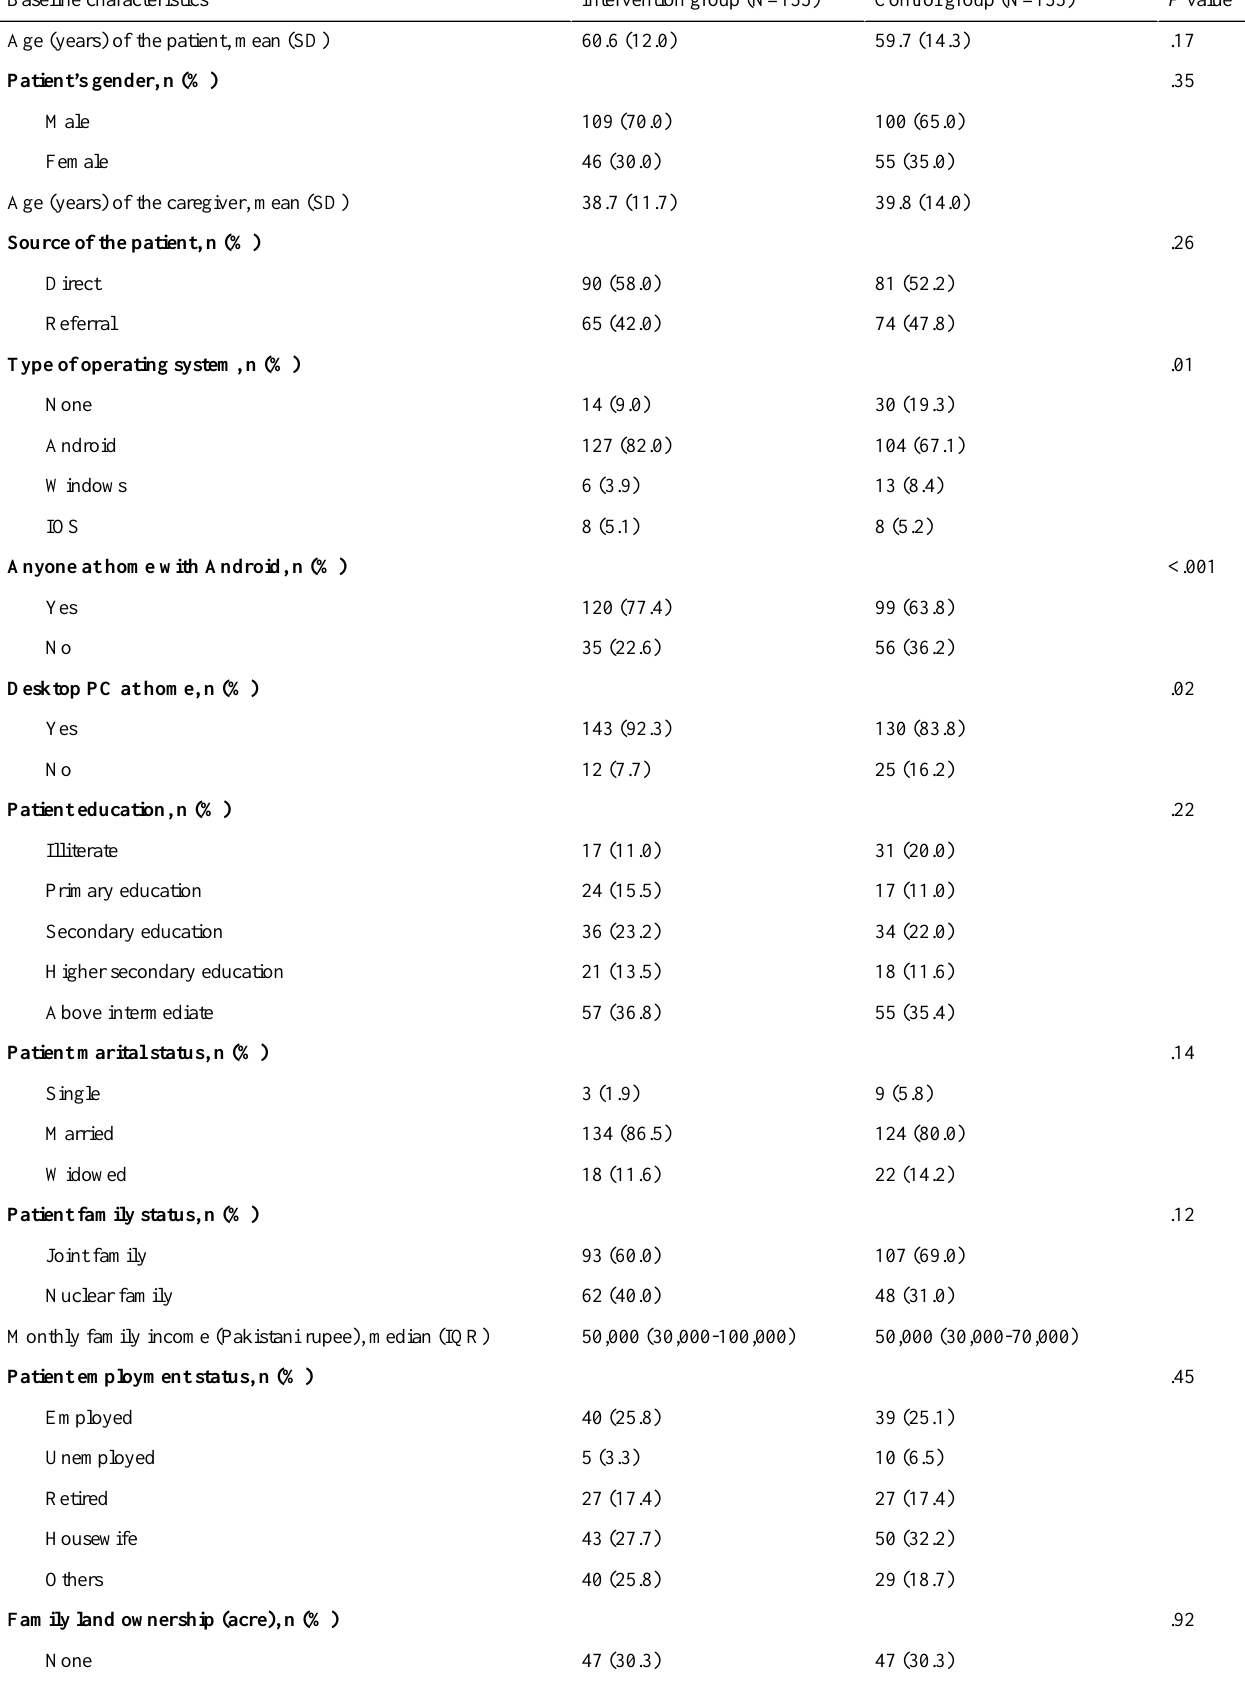
P valueControl group (N=155)Intervention group (N=155)Baseline